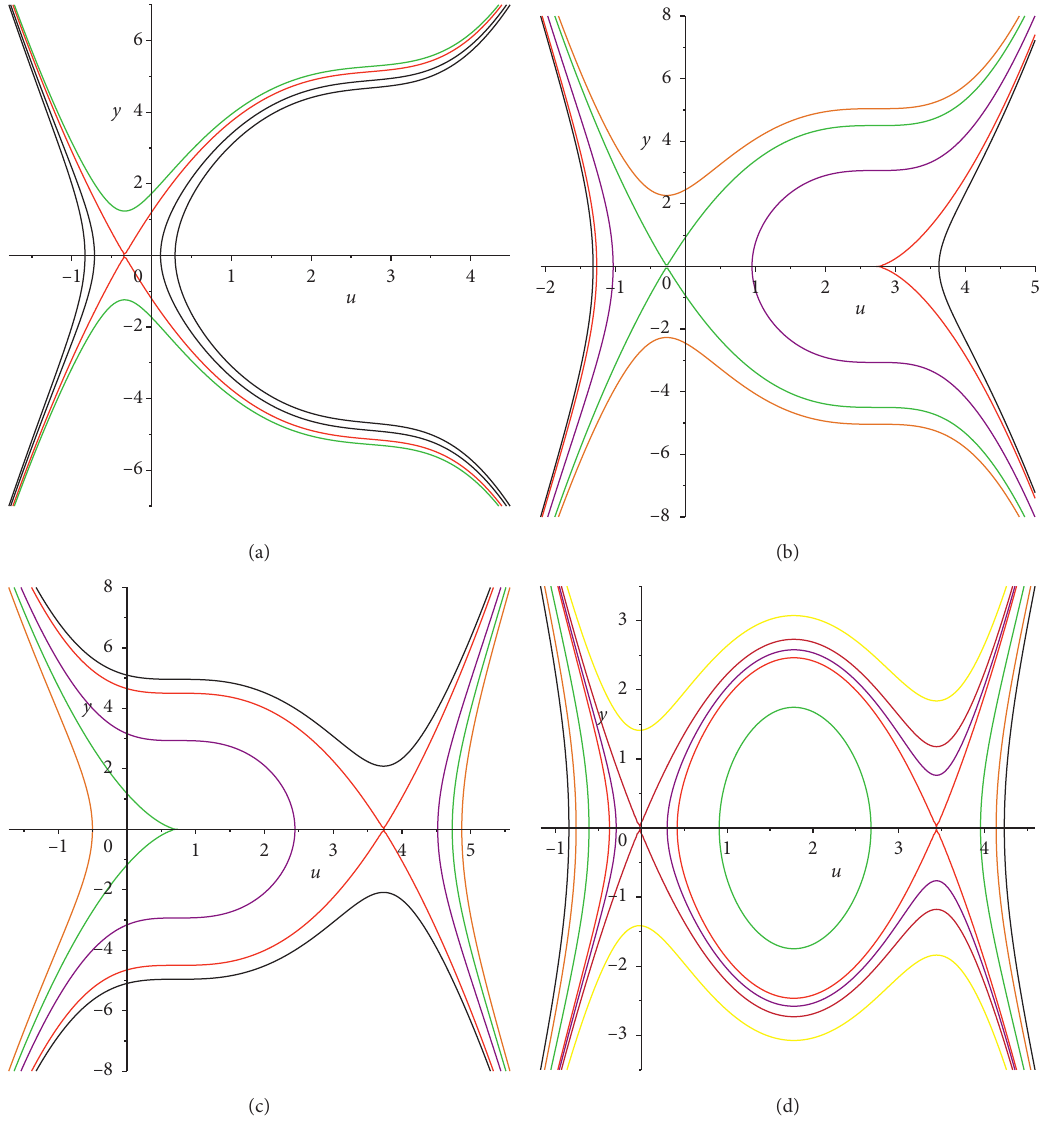
Figure 1: Bifurcation of phase portraits of system (9). (a) One equilibrium point. (b, c) Two equilibrium points. (d) Three equilibrium points. Parameters: (a) c � 4, l � points of intersection of the green curve with the u -axis in Figure 1(d)). Using the formula (see 254.00